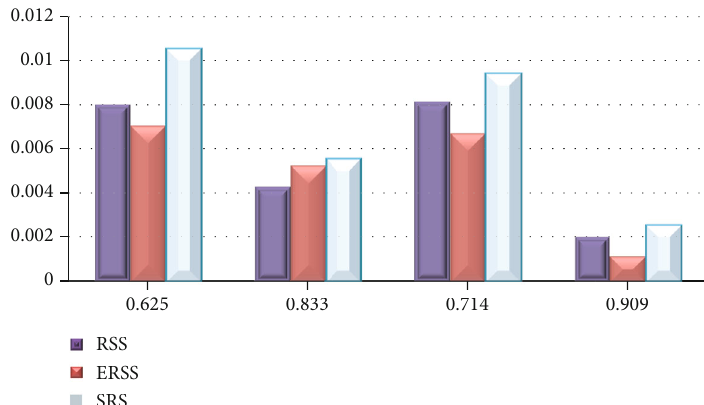
, m = ð 2, 2 Þ 1 2 Þ